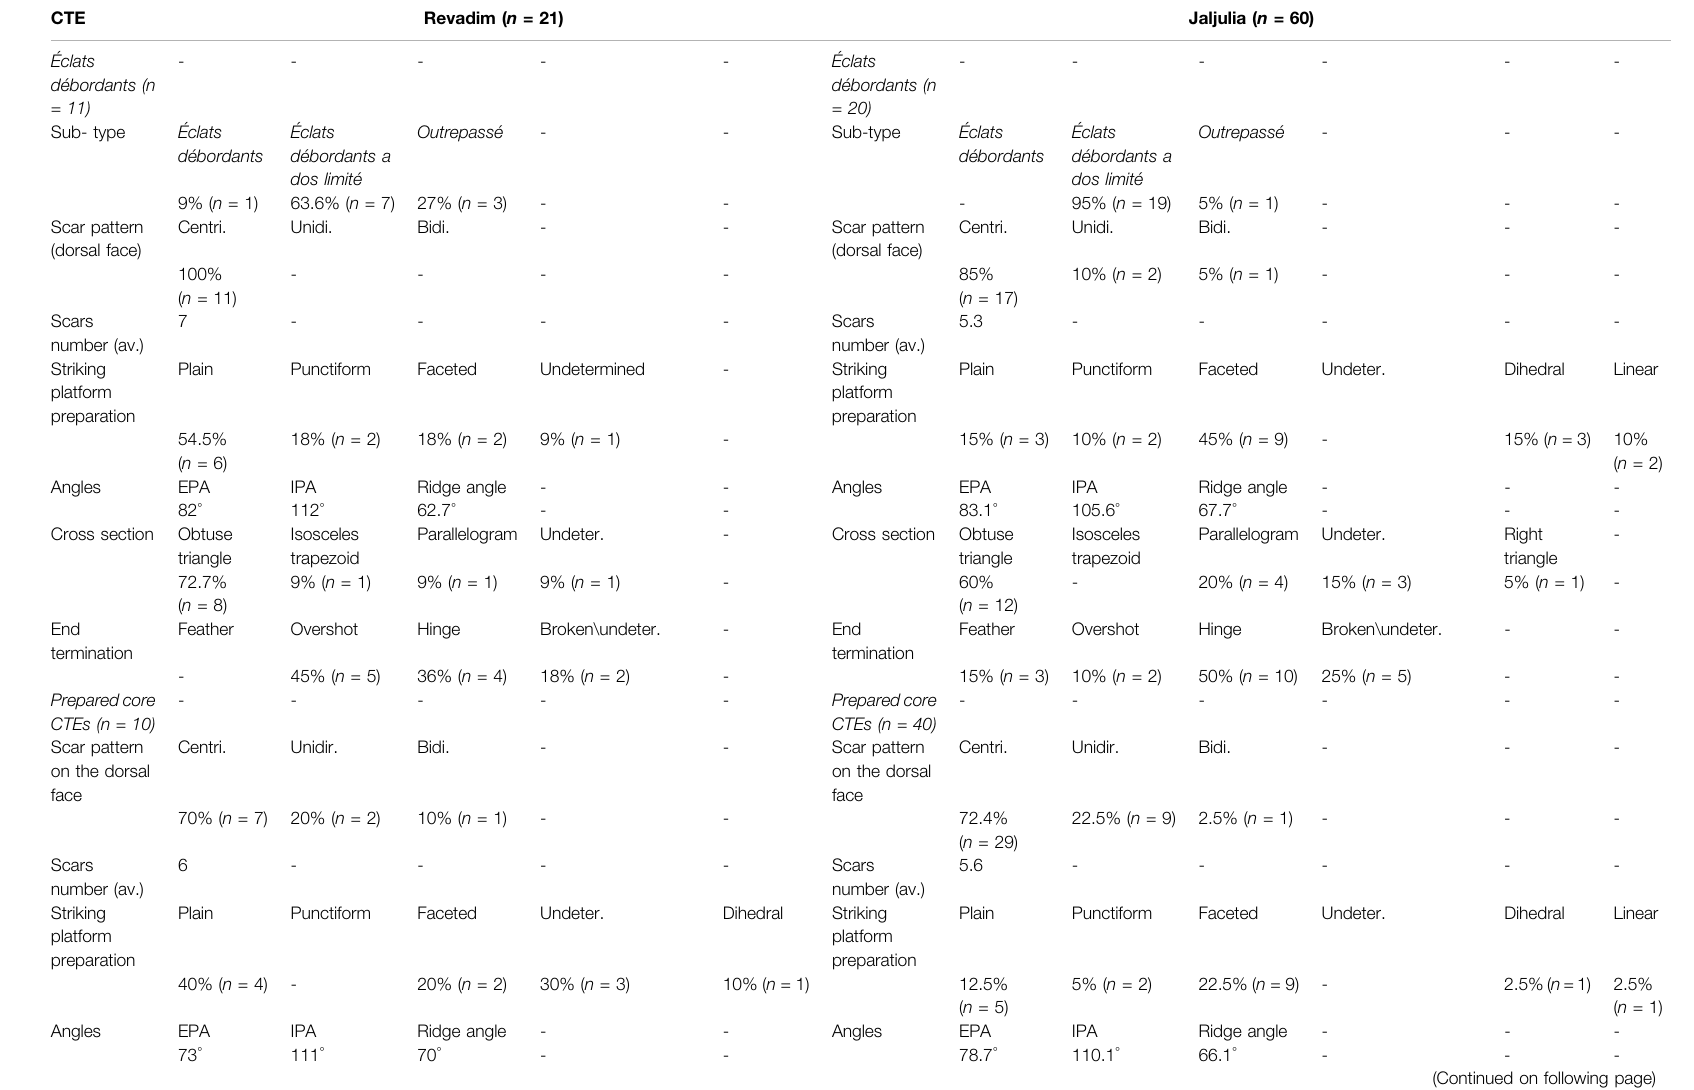
TABLE 5 | Major attributes of the two CTE types from both sites. Prefer. (Preferential); Rec. (Recurrent); centri. (centripetal); uni. (unidirectional); bidi. (bidirectional); Undeter. (Undetermined).